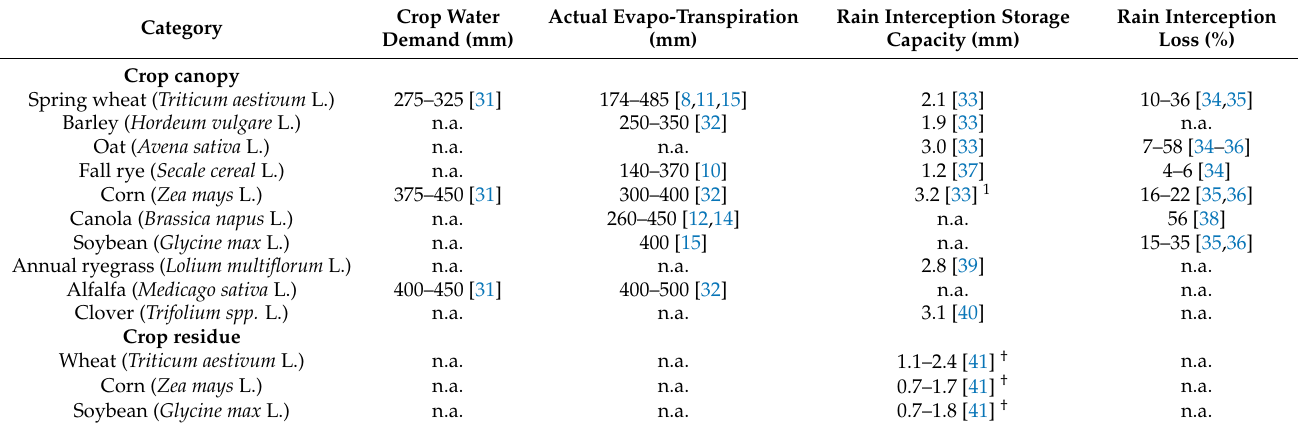
Crop Water Actual Evapo-Transpiration Rain Interception Storage Rain Interception Demand (mm) (mm) Capacity (mm) Loss (%)